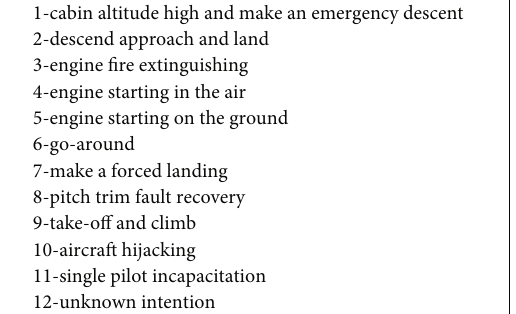
Figure 16: Label meanings of the numbers in Figures 14 and 15.